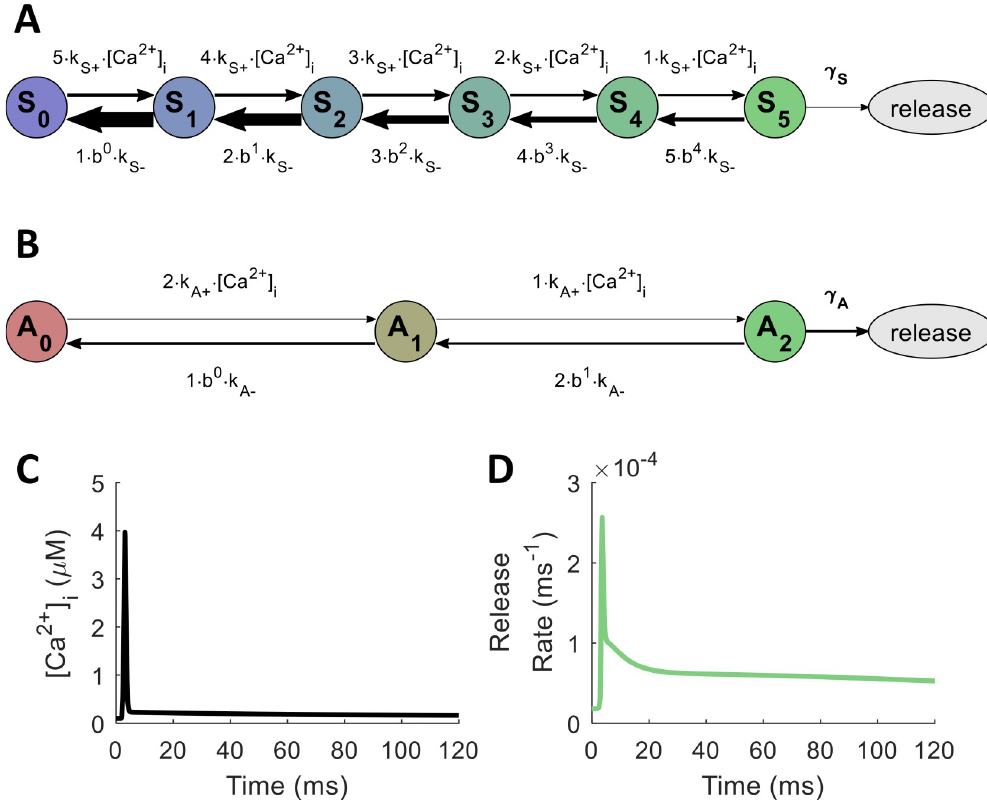
Fig 3. Model of Ca 2+ -Evoked, Synaptotagmin-Mediated Neurotransmitter Release. (A,B) Model adapted from Sun et al. [5]. γ S and γ A represent rates of vesicle fusion from the releasable states of the synchronous and asynchronous mechanisms, respectively. (A) Ca 2+ -bound states for Syt-1 (synchronous release); S n indicates n Ca 2+ ions bound to the synchronous release mechanism. (B) Ca 2+ -bound states for Syt-7 (asynchronous release); A n indicates n Ca 2+ ions bound to the asynchronous release mechanism. (C,D) Action-potential-like stimulus delivered to model axon starting at 0 ms. Diffusion is assumed to be instantaneous, and molecular state probabilities are tracked deterministically over time. (C) Free [Ca 2+ ] i in response to single action potential. (D) Instantaneous vesicle release rate in response to buffered Ca 2+ from both synaptotagmin-mediated release mechanisms.